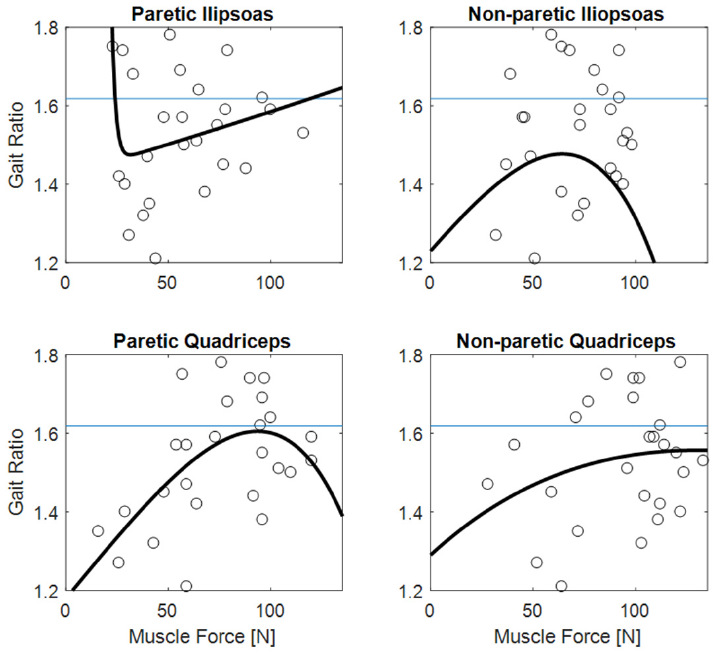
Figure 4. The gait ratio (stride duration/stance duration) reported with respect to paretic and non- paretic muscle forces. The horizontal blue lines represent the theoretical value of the golden ratio (about 1.618); the wide black bioexponential lines poorly fitted the data.